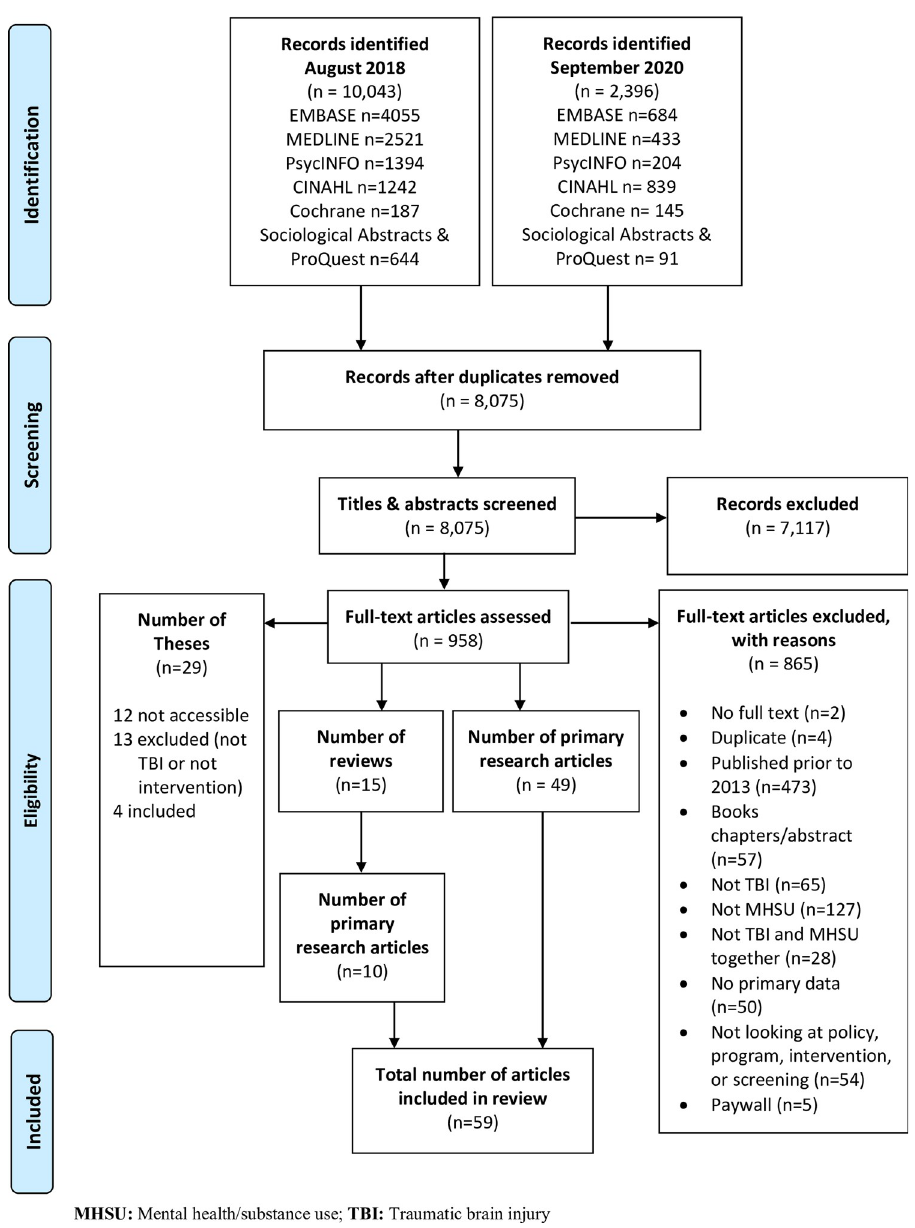
Fig 1. PRISMA flow